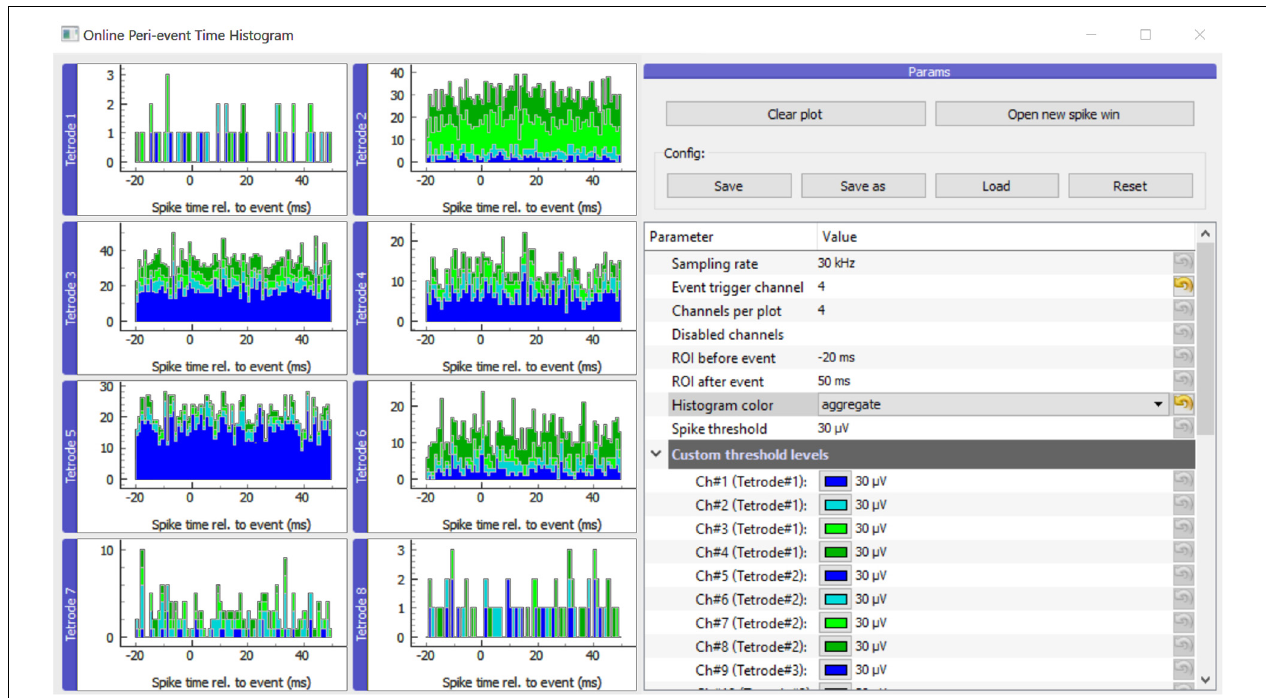
FIGURE 2 | Main GUI of OPETH. The histograms of the different channels or polytrodes are displayed on the left side of the window. The menu on the right side allows changing the parameters and interacting with the GUI. Histogram channels are collected in groups of four by default as for classical tetrode recordings. In order to adapt the plot to other channel configurations, the “Channels per plot” option can be set from 1 to 8 allowing visualization for single electrodes, stereotrodes or silicon